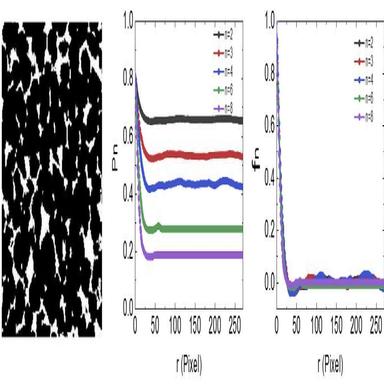
(a) 2D image of an interpenetrating metal-ceramic composite microstructure composed of the boron-carbide phase (shown in black) and the aluminum phase (shown in white). (b) The Pn functions for the boron-carbide (black) phase with n ¼ 2, 3, 4, 6 and 8. (c) The corresponding rescaled fn functions highlighting the spatial correlations (c.f. Eq..